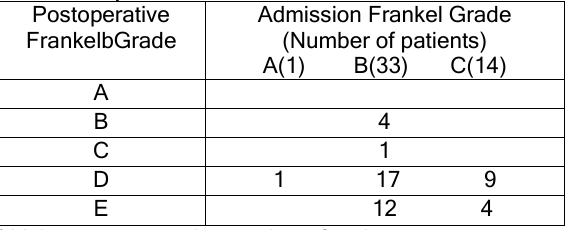
Table 2. Summary of Frankel grades at admission